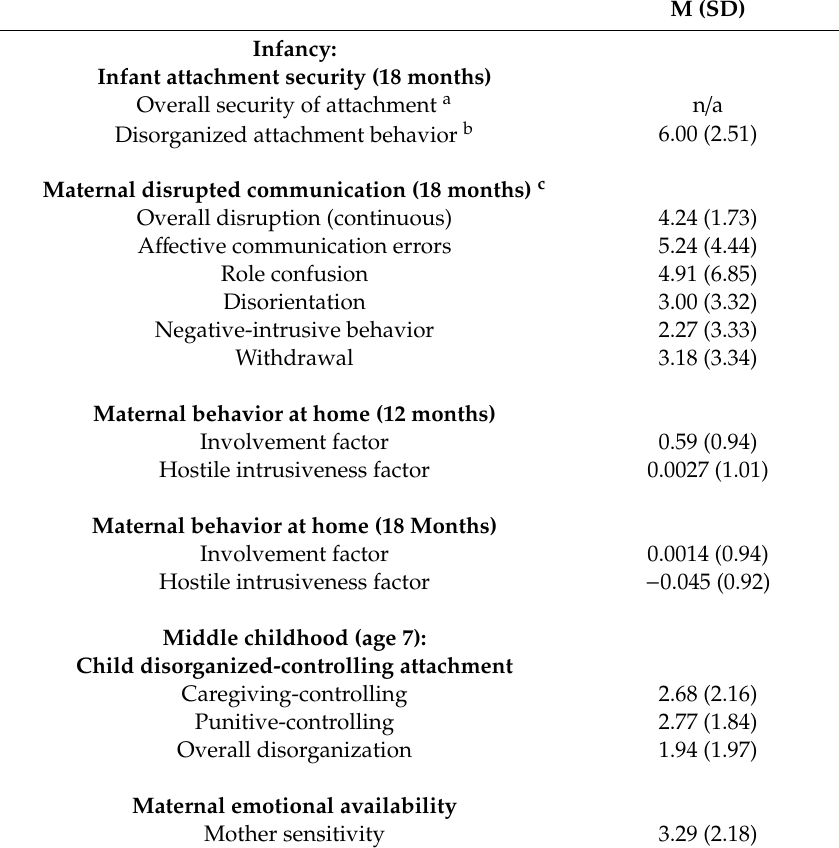
Table 1. Descriptive characteristics for continuous